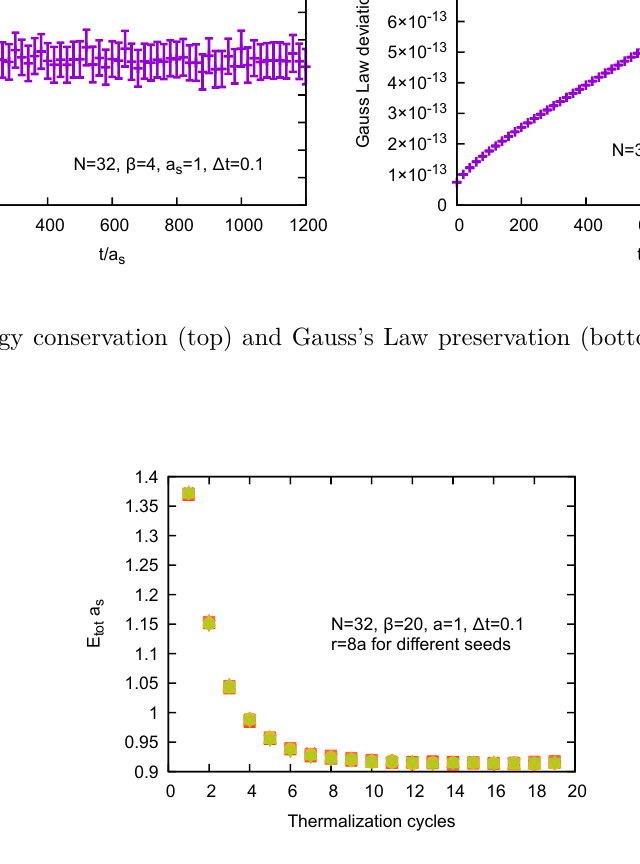
Figure 13 . Thermalization of the initial conditions in the presence of sources at spatial distance r=a at β = 20